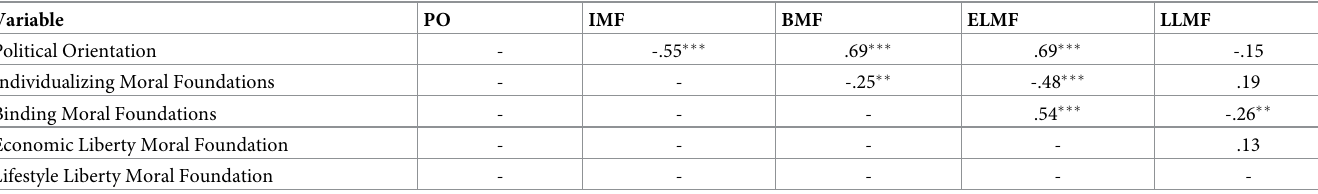
Table 5. Correlation matrix for key political and moral variables in U.S. sample (n = 109).